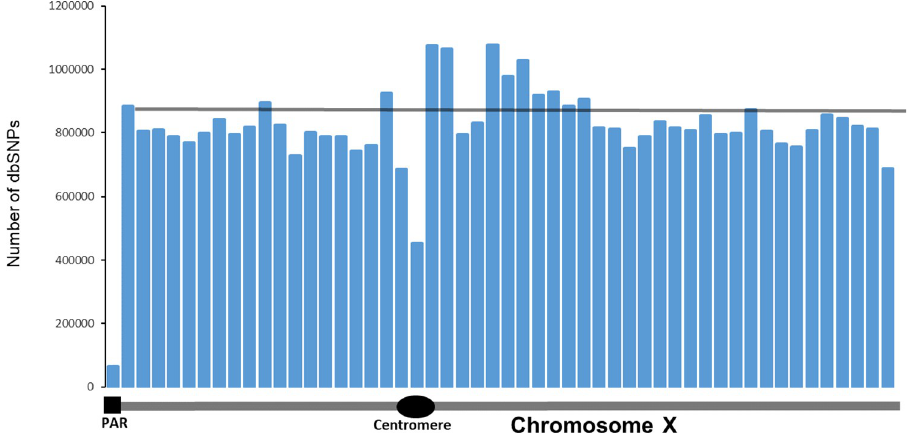
Fig 9. The distribution of the number of SNPs reported in dbSNP database. Each bar represents a 3-megabase fragment of X-chromosome. The first bar corresponds to the position and size of the pseudoautosomal region 1. Thin gray horizontal line represents the average number of SNPs in all bars except